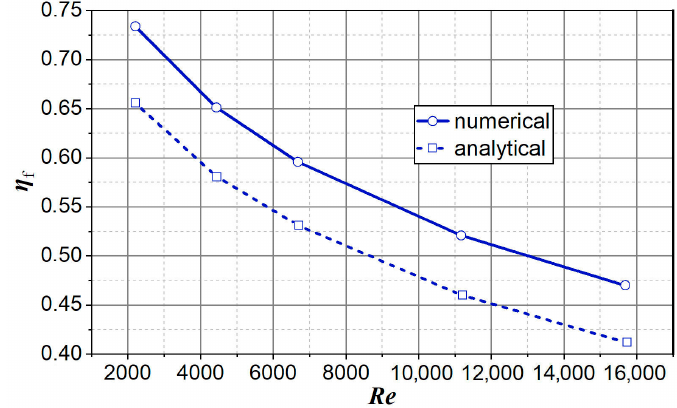
Figure 16. The efficiency of fins determined numerically and analytically.